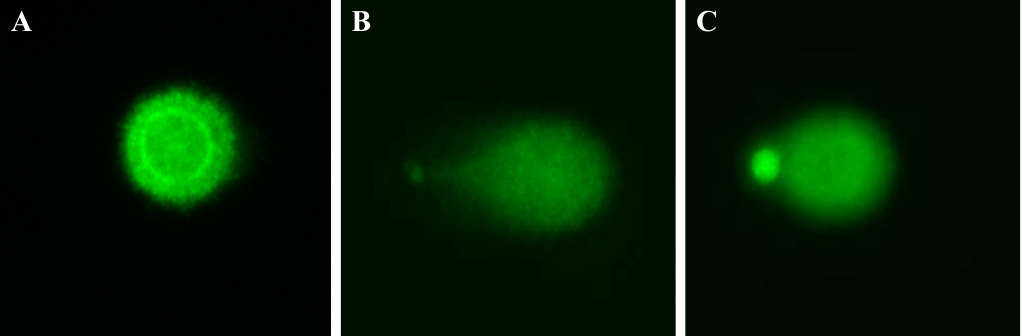
Figure 3. Representative images of Comet assay analysis of MCF10A cells. ( a ) Untreated cell, showing a circular shape indicating absence of DNA damage; ( b ) 10 min. H exposed cell, exhibiting a long and bright tail related to DNA strand breaks, indicating DNA oxidative damage; ( c ) 10 min. H pretreatment, illustrating the reduction of tail length and fluorescent intensity indicative of reduced DNA damage.